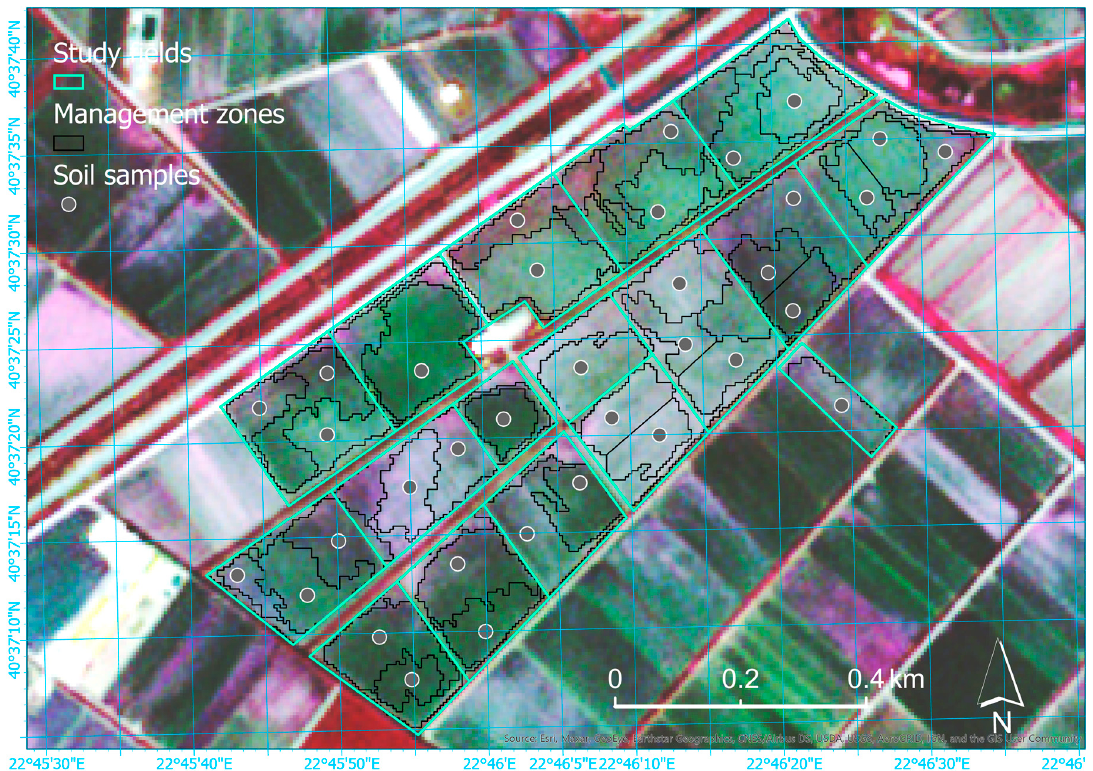
Figure 6. The management zones resulted from image segmentation of the multi-temporal RapidEye image composite on a scale factor of 150; a zoom in the central sector of the rice farm.